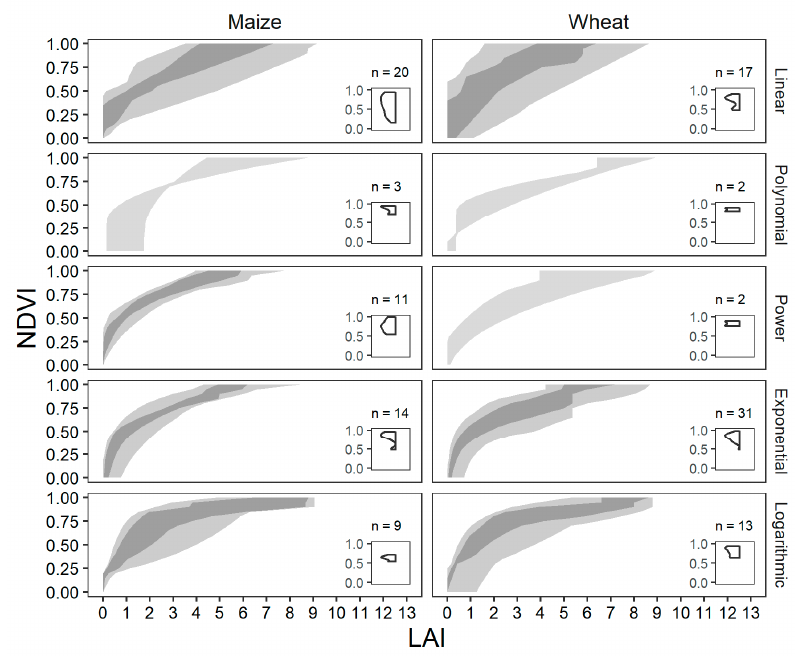
Figure 2. Correlation plots between the positive part of the normalized difference vegetation index (NDVI) existence range and leaf area index (LAI) for maize and wheat, sorted by mathematical form. The grey shadows indicate the 5–95th (light grey) and the 25–75th percentile (dark grey) of the LAI values obtained from the equations considered. The half-violin plot shows the R 2 distribution; n is the number of equations.